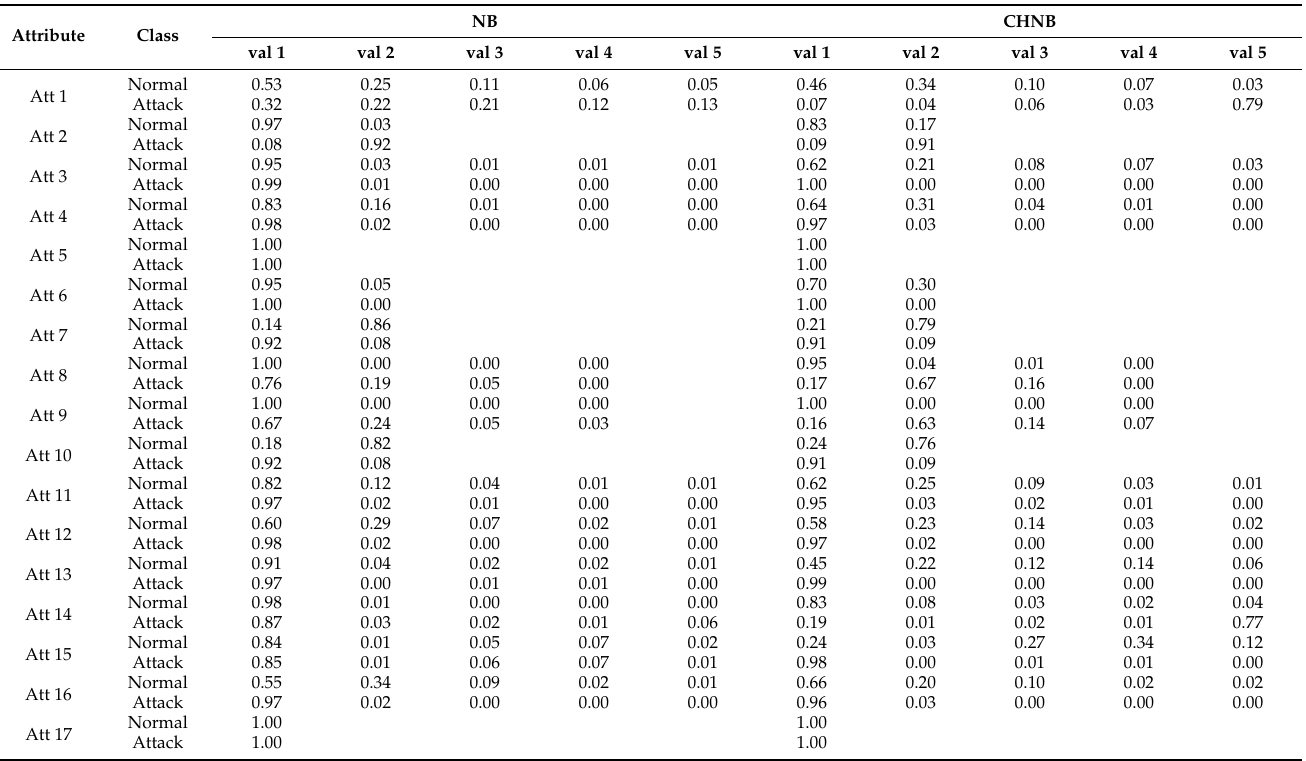
Table 8. The probability terms for the binary-class dataset before and after fine-tuning.